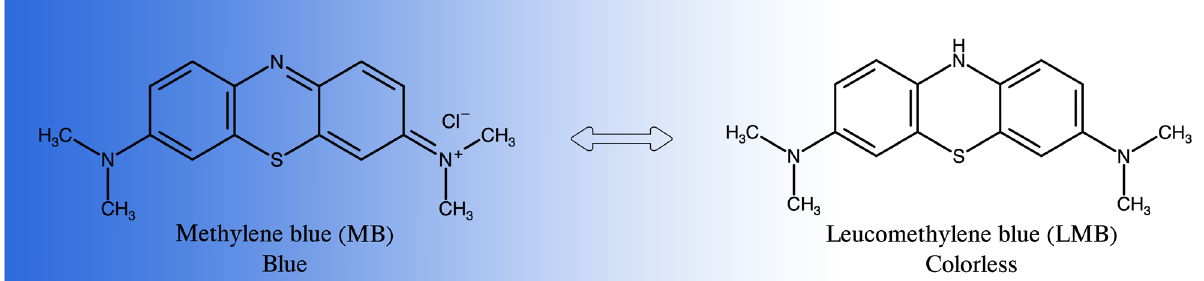
Figure 1. Chemical structures of methylene blue and leucomethylene blue.